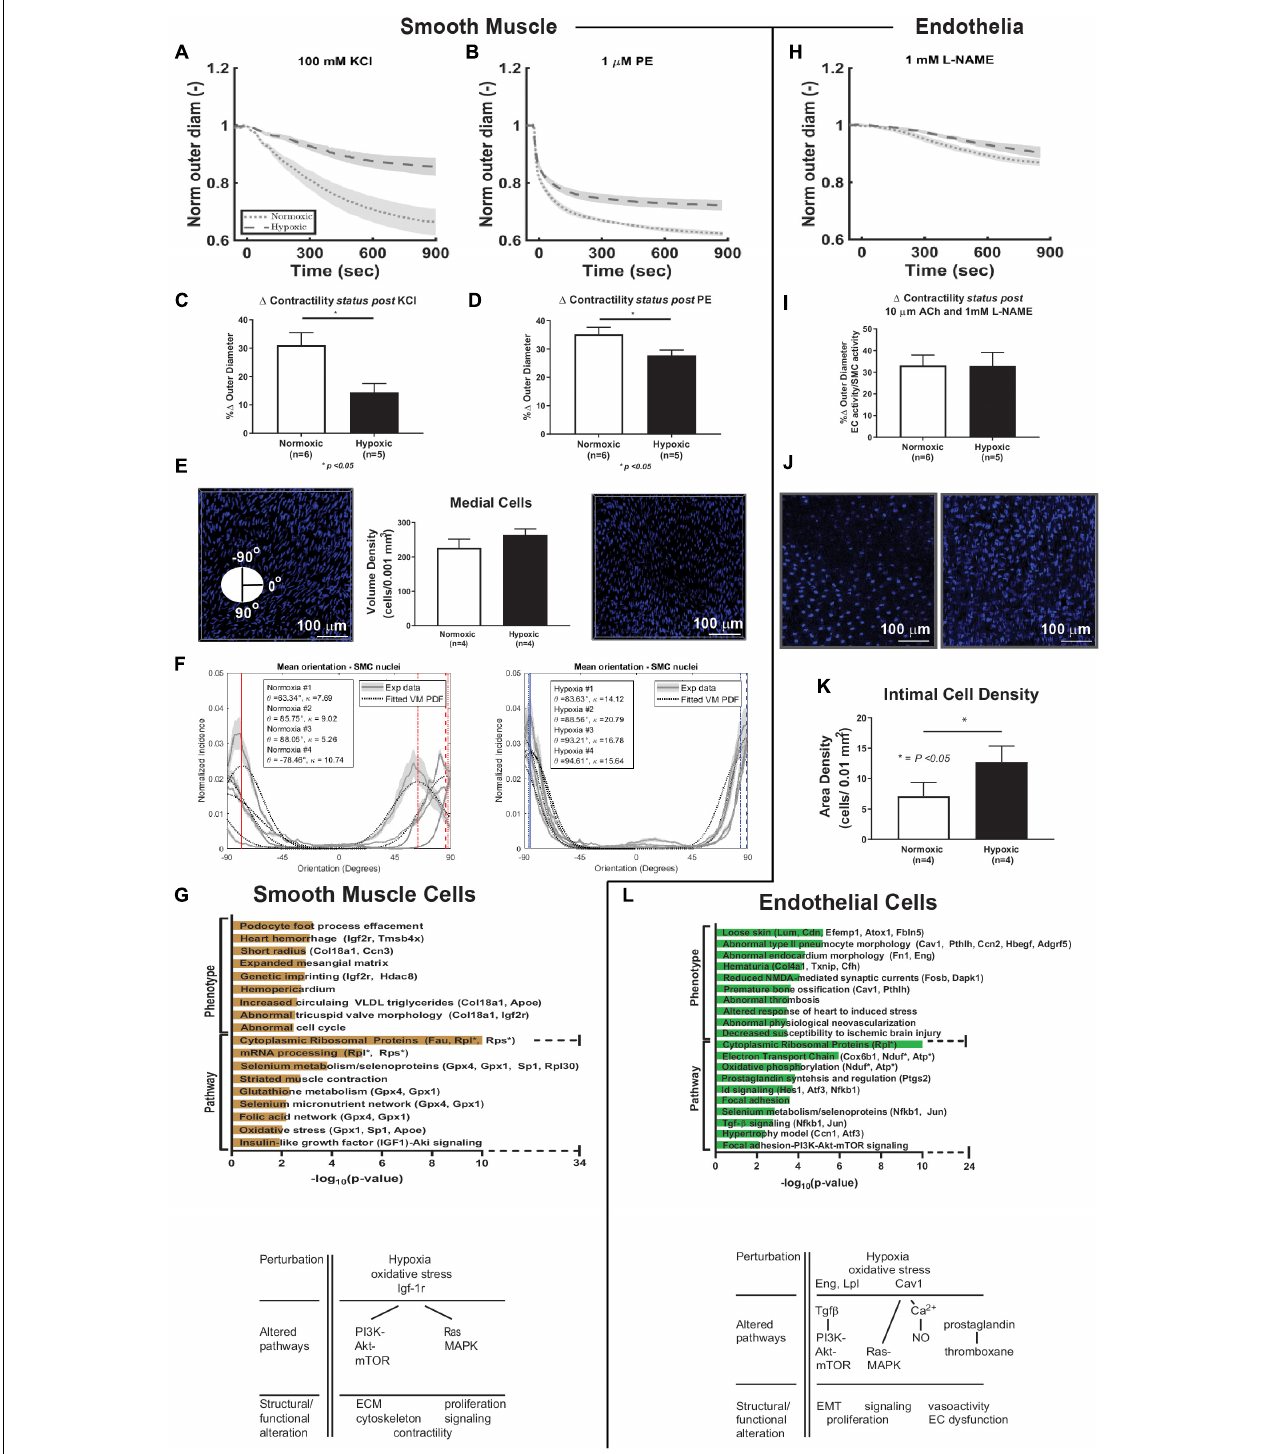
FIGURE 4 | Smooth muscle cell and endothelial cell functional-transcriptomics. (A,B) Vaso-constriction response to vasoactive substances, potassium chloride (KCl) and phenylephrine (PE), as a function of time plotted as mean (dashed and dotted lines) ± standard error from the mean (shade) for normoxic (dotted, n = 6) and hypoxic (dashed, n = 5) samples. Vessels were maintained at a fixed pressure (15 mmHg) and specimen-specific optimized axial stretch. (C,D) Percent change in contractility based on normalized outer diameter change at the end of 15 min exposure to KCl and PE. There is a significant decrease in contractility of